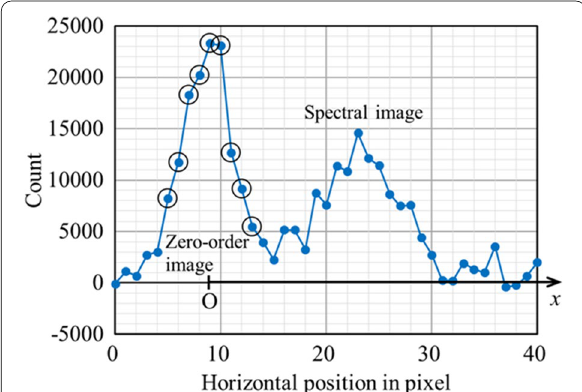
Fig. 8 The count profile of the zero-order and spectral images of Flash 170201 (2nd-frame). The dark frame and the lunar background have been subtracted. The abscissa shows the distance along the spectral image from an arbitrary point. The atmospheric dispersion elongates the zero-order profile. We used the plots of more than 5000 in count (encircled by the rings) to determine the center of count of the zero-order image (O in the figure). The distance from the center is denoted by